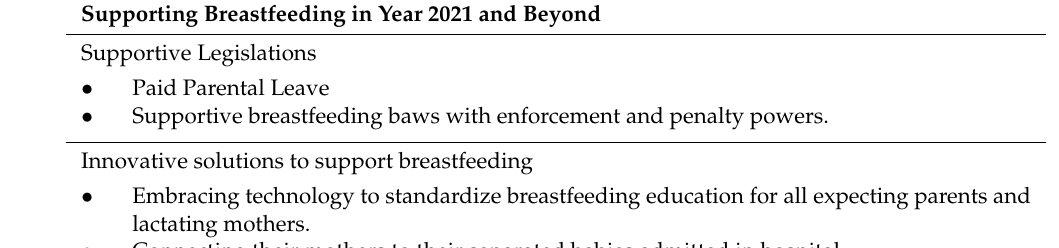
Table 1. Innovative solutions to facilitate